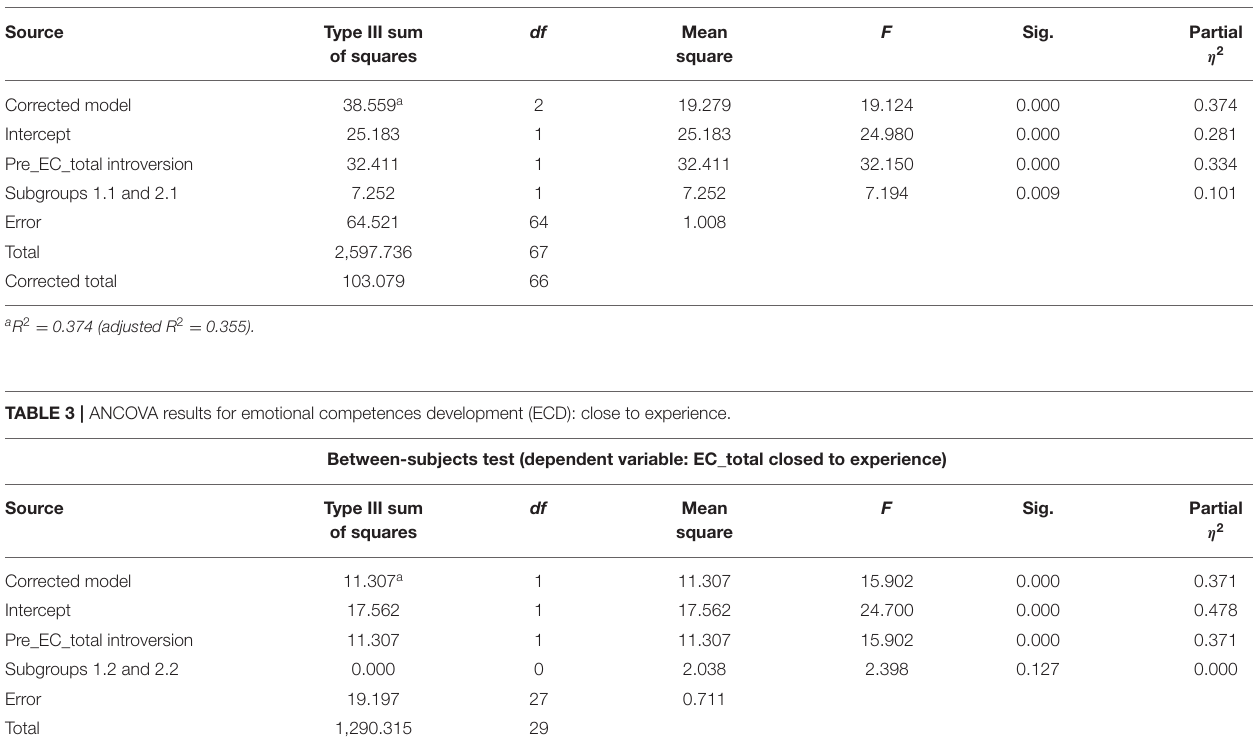
TABLE 2 | ANCOVA results for emotional competences development (ECD): introversion. Between-subjects test (dependent variable: EC_total introversion)